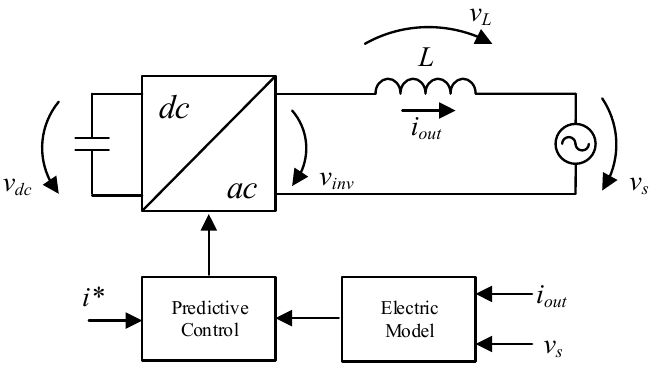
Figure 10. Simpli fi ed diagram of the electrical system for the predictive control algorithm. Figure 10. Simplified diagram of the electrical system for the predictive control